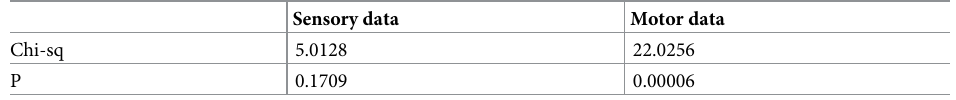
Table 5. Differences among the most reliable results of each non-deterministic algorithm.